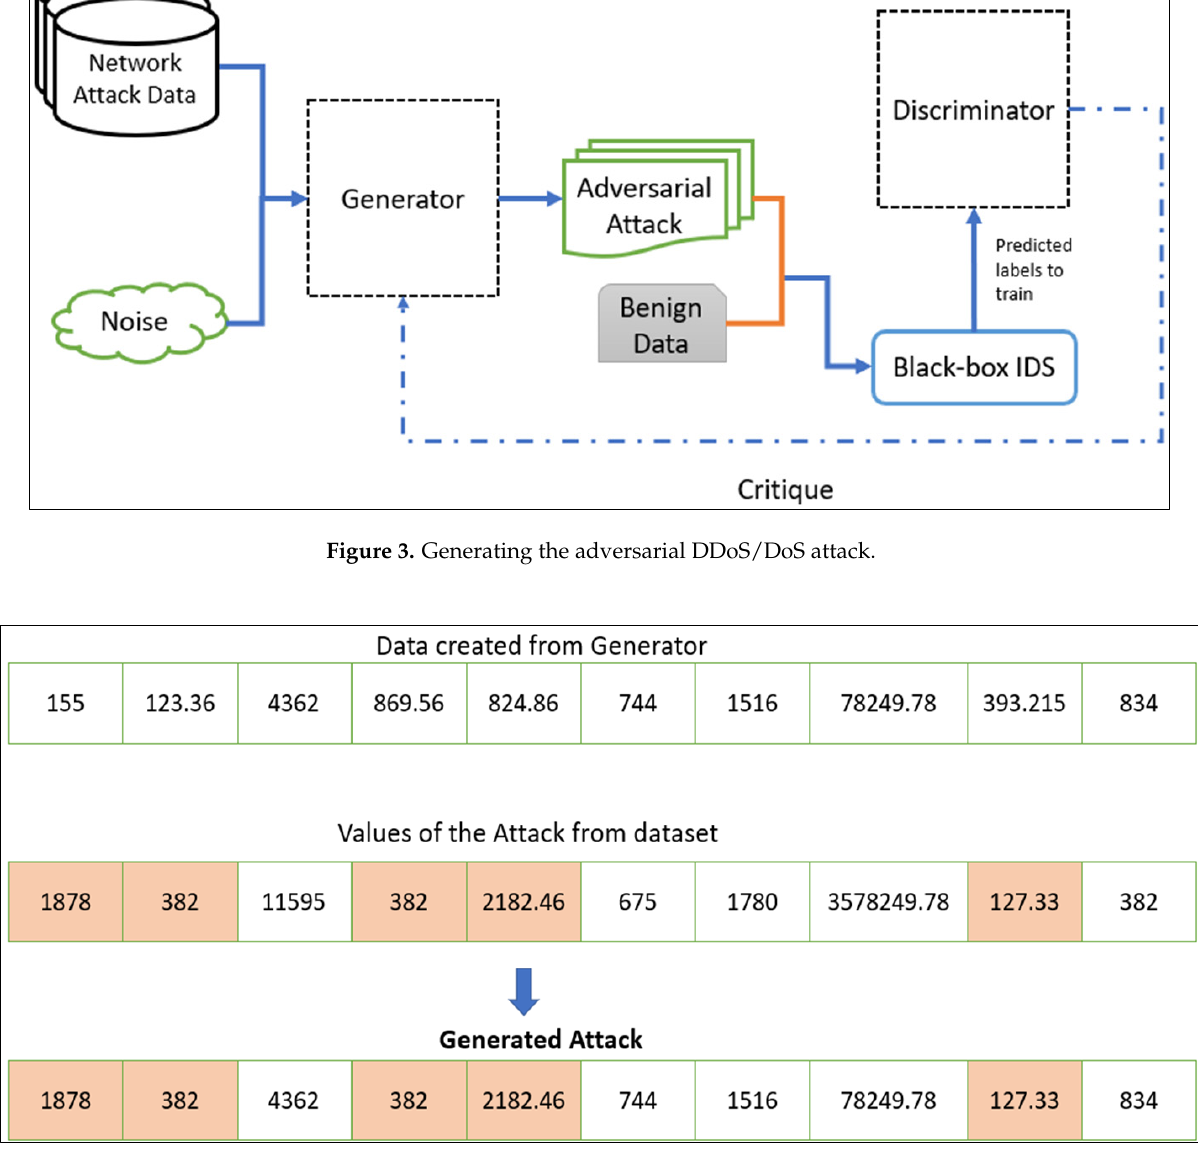
Figure 4. The process to generate the adversarial DDoS/DoS attack.